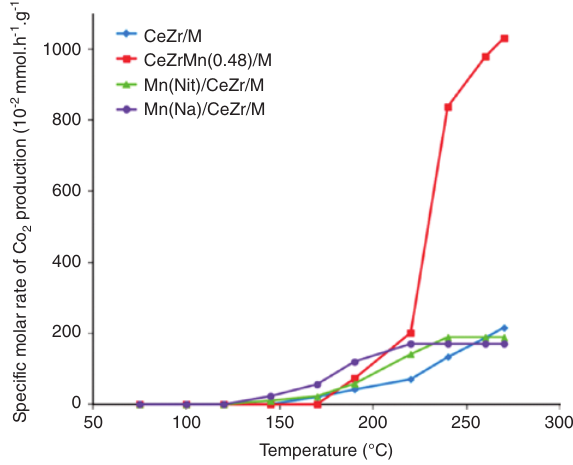
production as a function of 2